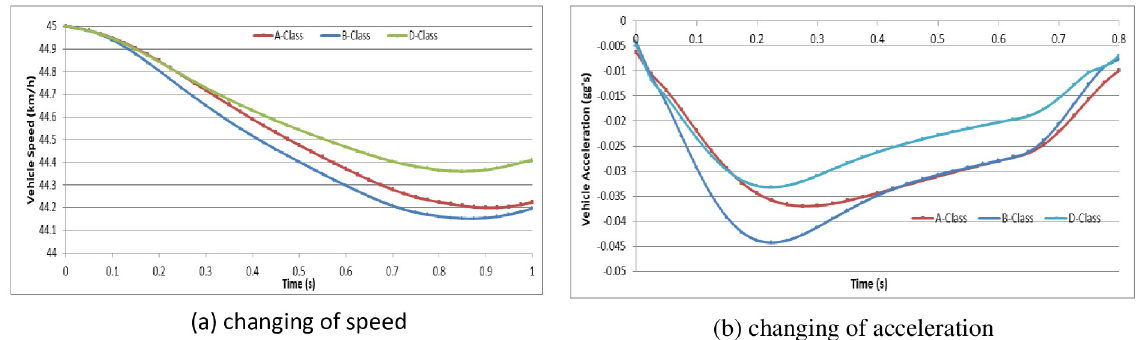
Fig 11. The changes in vehicle speed and acceleration during the reactions at initial speed = 45 km/h with different vehicle models (Group 1).